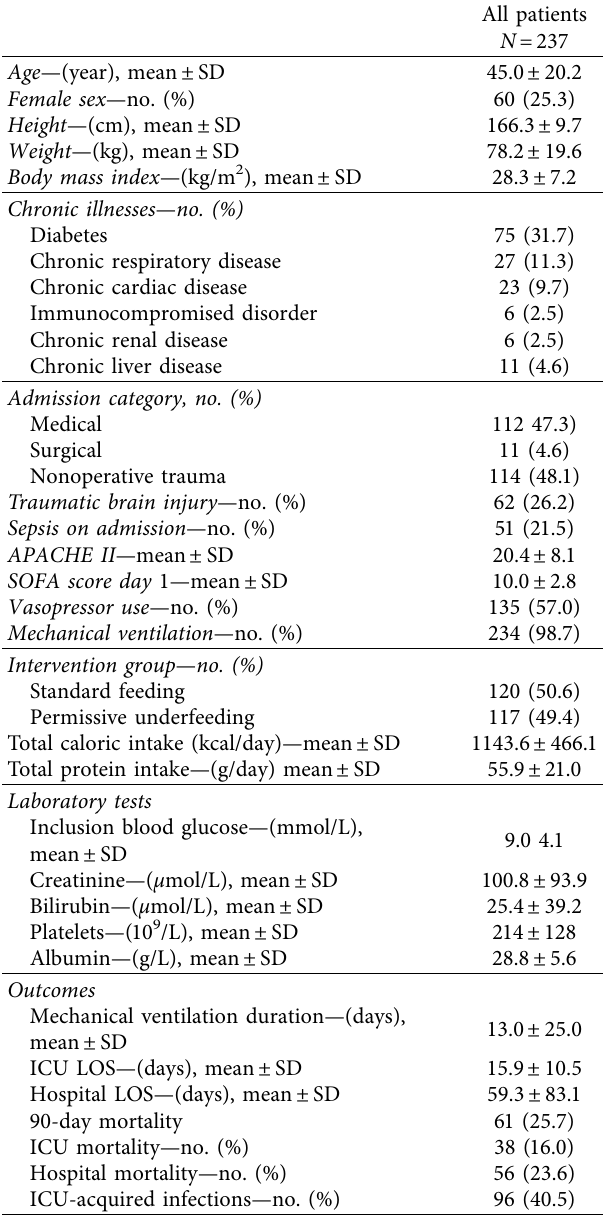
Table 2: Characteristics and outcomes of the 237 patients in the study cohort.